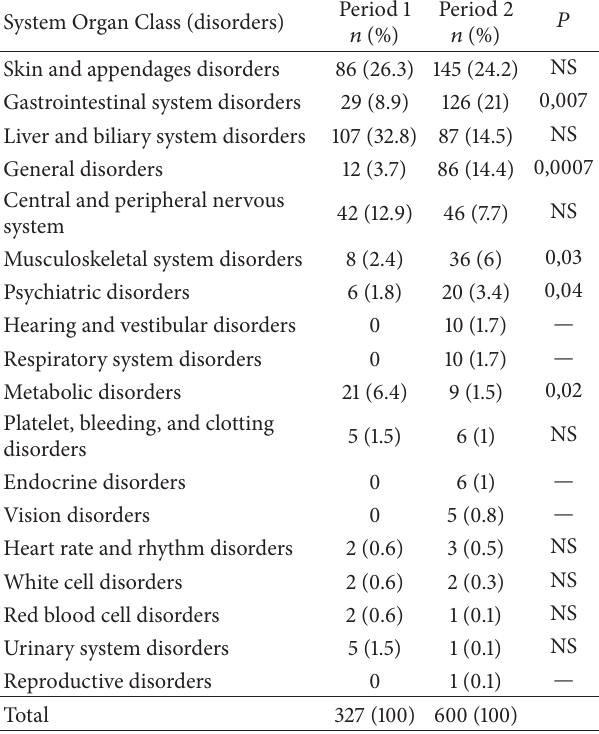
Table 3: Comparison of ADRs types before and after integration of PV-MTCP.